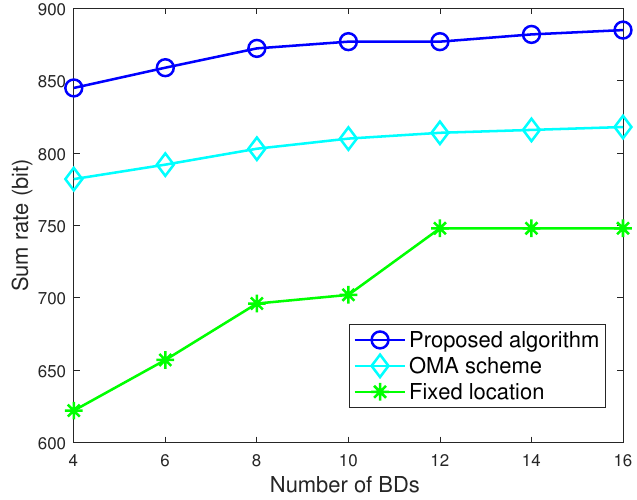
Figure 5. The sum rate w.r.t. the number of BDs.